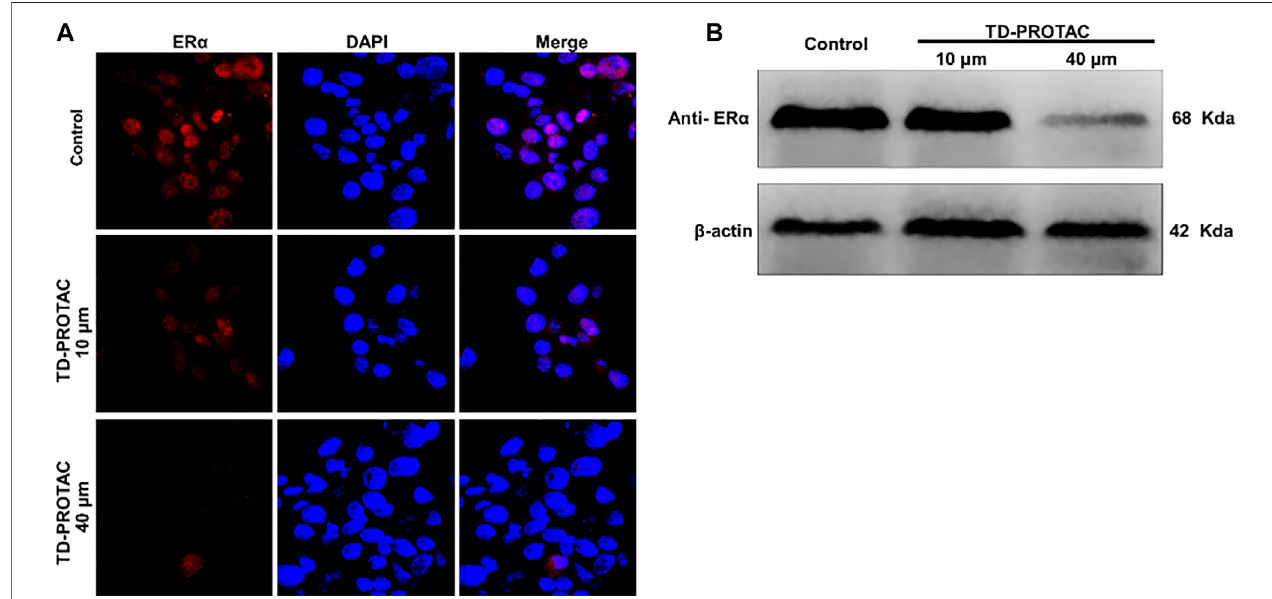
FIGURE 2 | The effect of TD-PROTAC on ER α expression in chondrocytes. (A) Immuno fl uorescence analysis of ER α after staining with a secondary Cy3- conjugated antibody (red). Nuclei were stained with DAPI (blue). (B) Western blot analysis of ER α after treatment of cells with TD-PROTAC. Chondrocytes were treated with TD-PROTAC at the indicated concentrations for 24 h.